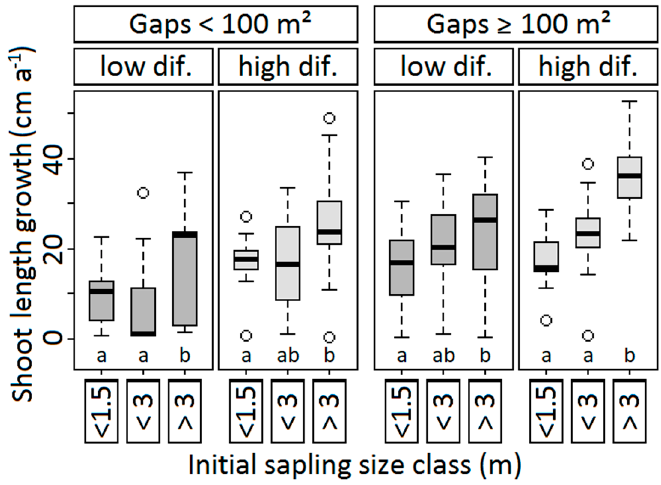
Figure 4. Shoot length growth of saplings in squares exposed to different levels of diffuse radiation (relatively low: dark grey; relatively high: light grey) in gaps of two size categories ( < 100 m 2 and ≥ 100 m 2 ). Box-whisker plots with median (thick line), 25-and 75-percentiles (box) and extremes not exceeding the 1.5fold of the interquartile range (whiskers). Dots indicate extreme data points beyond 1.5 times the IQR.